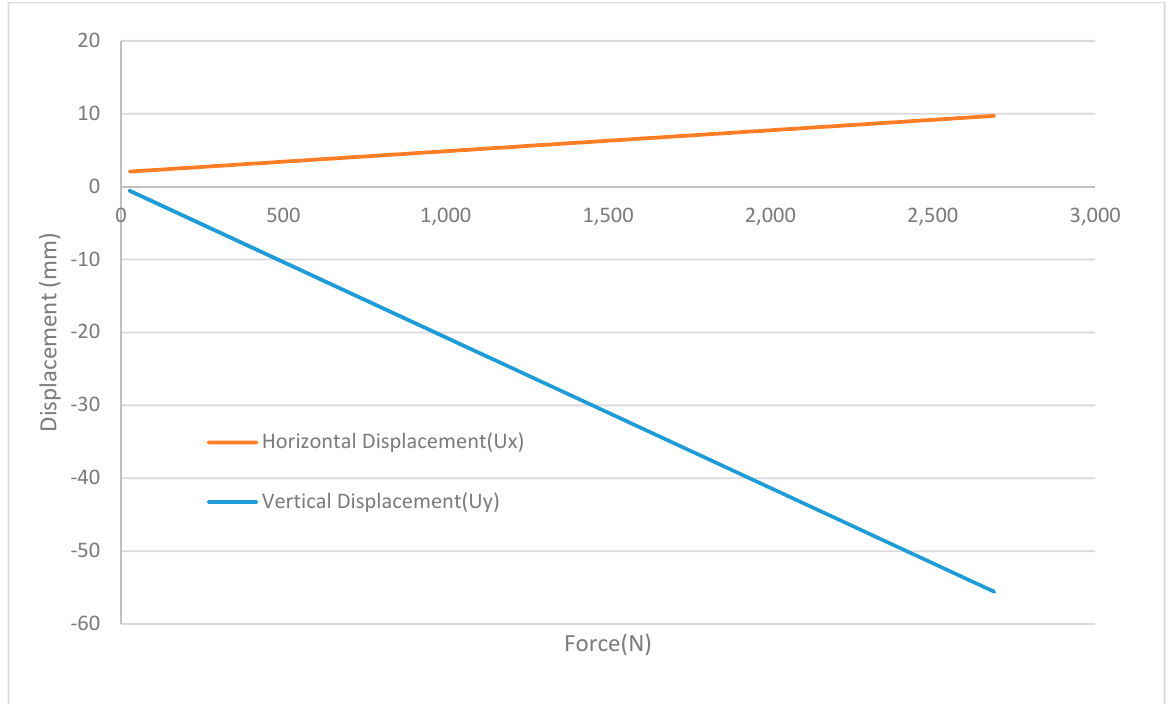
Figure 21. Horizontal and vertical displacements at node 20, element 1126 with coordinate details: ( x = 0, y = 0.25, z = − 4) and 30% FA.